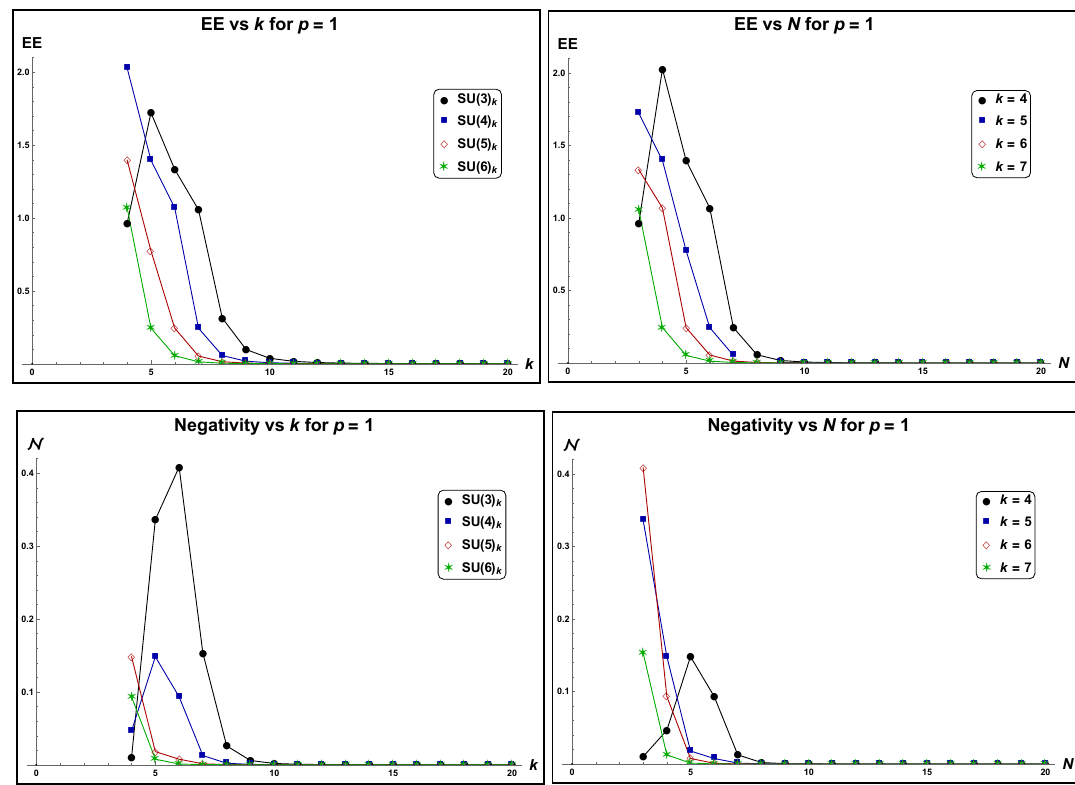
Figure 17 . Plots showing variation of SU( N ) k entanglement entropy and entanglement negativity obtained for the reduced density matrix of eq. (4.95) acting on the Hilbert space H zero values of N implies that it is non-separable and the state j (cid:9) ( n =3)